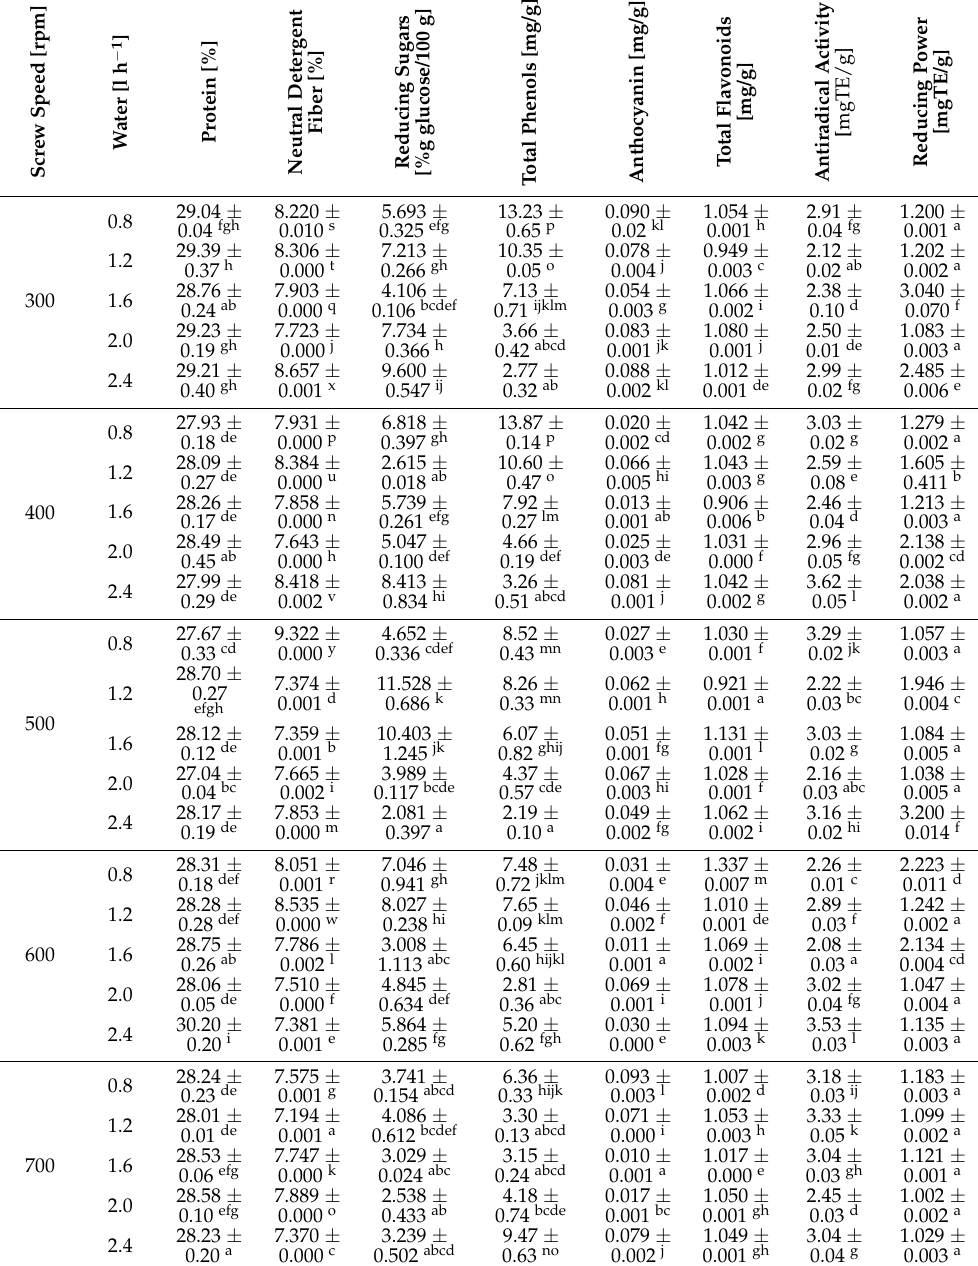
Table 1. Chemical and nutritional characteristics of red bean Toska extrudates processed at various